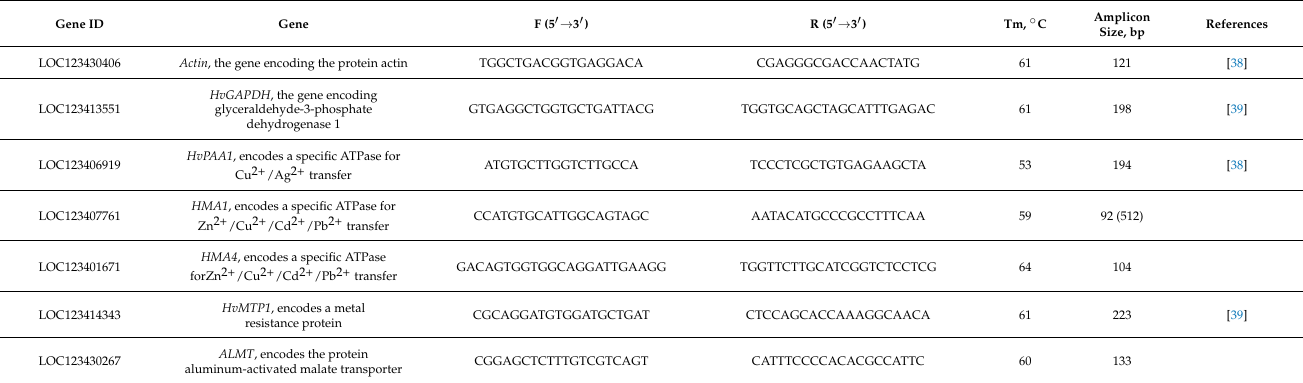
Table 2. List of genes, gene-specific primers, and PCR